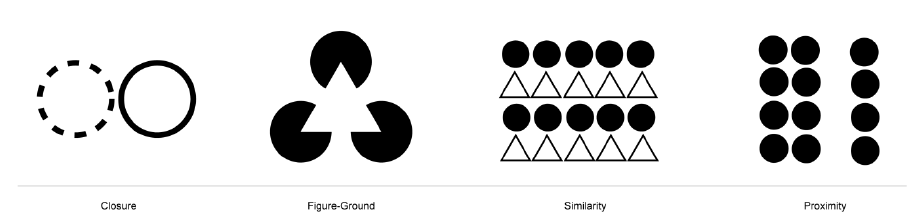
Figure 1. Illustrations of principles of gestalt (Zakia,